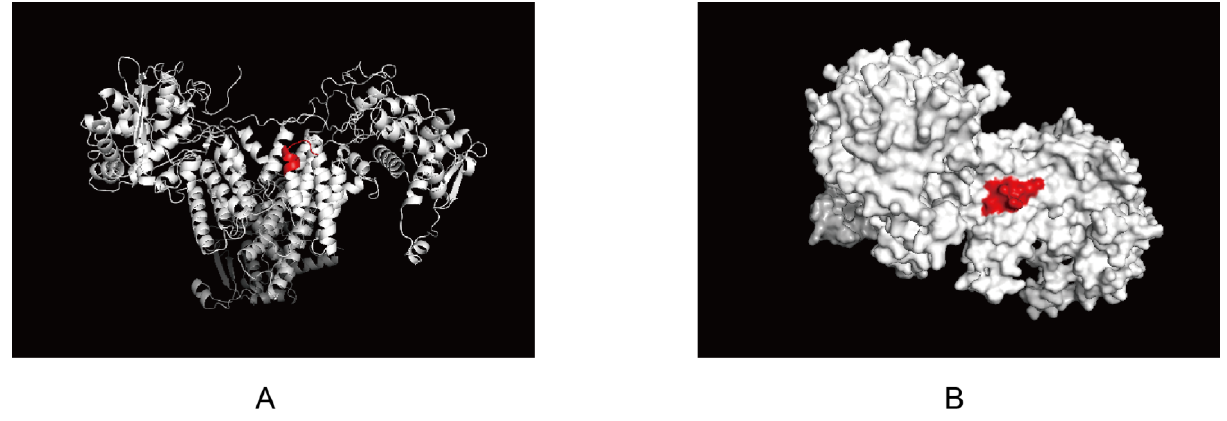
Figure 5. Localization of the identified epitope specific to NP protein: ( A ) Epitopes recognized by 4F5 mAb located at the junction of α‐ helix. This epitope was analyzed with “pymol”, which is marked in red; ( B ) Epitopes recognized by 4F5 mAb exposed on the surface of NP protein. This epitope was analyzed with Pymol. The epitope was exposed to the surface of NP protein and is marked in red.